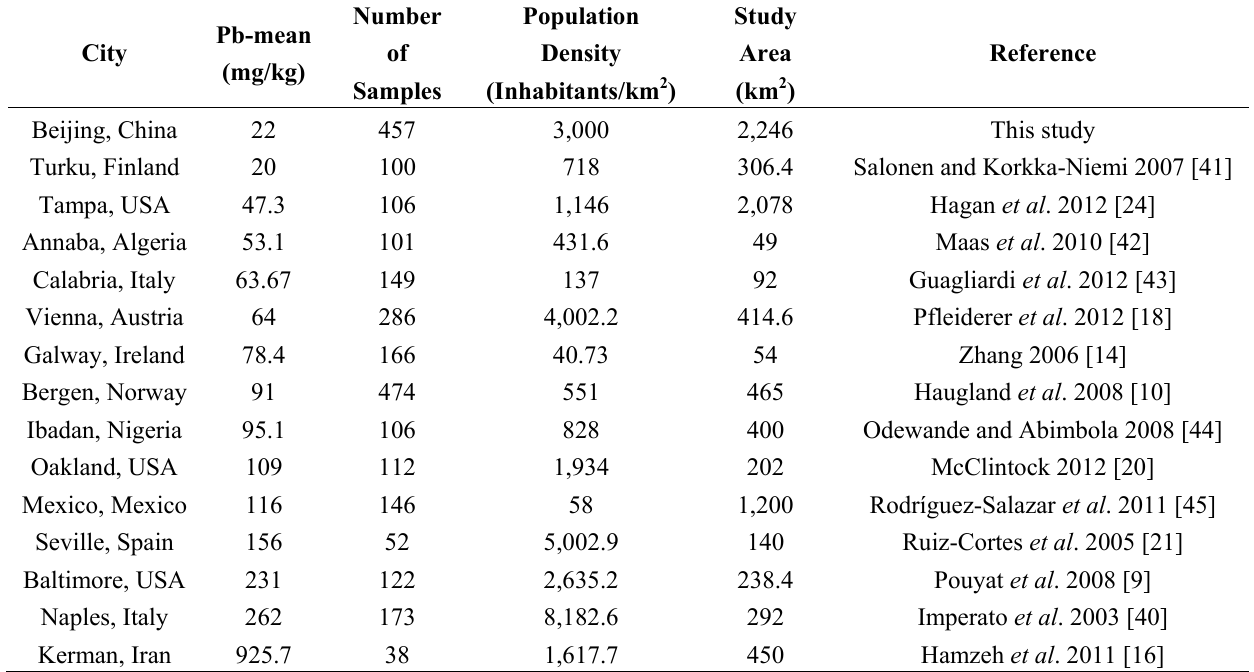
Table 5. Urban soil Pb levels in different